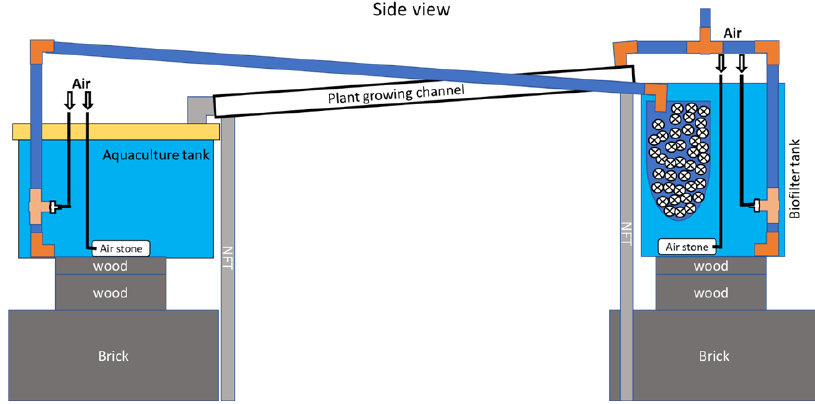
Figure 1. Schematic diagram of NFT aquaponic systems.